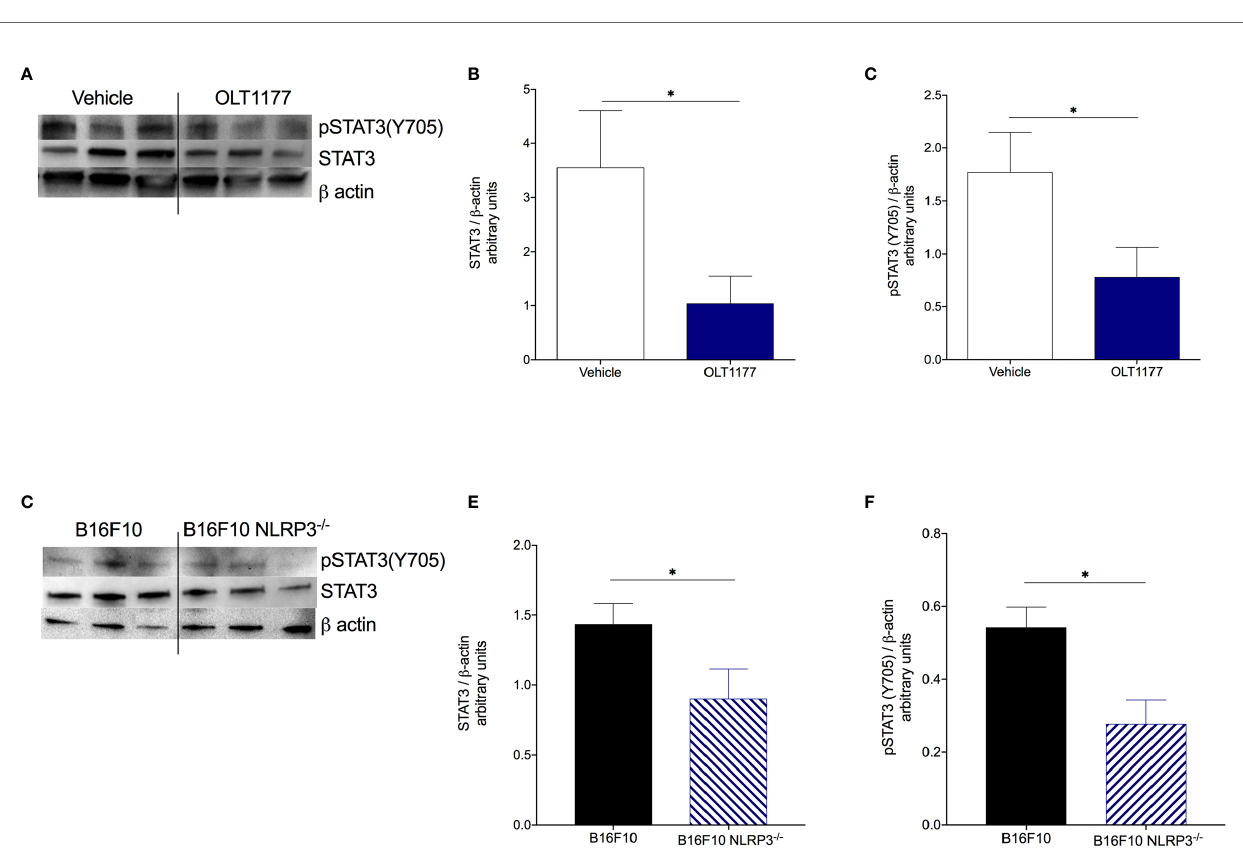
FIGURE 3 | Tumor-NLRP3 drives IL-6/STAT3 signaling in the bone marrow. (A – C) Mice were implanted with B16F10 and treated with saline control (Vehicle) or OLT1177 (OLT1177), on day 15 bone marrow was assessed via western blot. (A) Representative western blot images from (B, C) . (B) Mean ± SEM of STAT3/ b - actin ratio in bone marrow of mice described in (A – C) (N=6). (C) Mean ± SEM of pSTAT3(Y705)/ b -actin ratio in bone marrow of mice described in (A – C) (N=6). (D – F) Mice were implanted with B16F10 or B16F10 NLRP3 -/- cells, on day 15 bone marrow was assessed via western blot. (D) Representative western blot images from (E, F) . (E) Mean ± SEM of STAT3/ b -actin ratio in bone marrow of mice described in (D – F) (N=6). (F) Mean ± SEM of pSTAT3(Y705)/ b -actin ratio in bone marrow of mice described in (D – F) (N=6). * p <